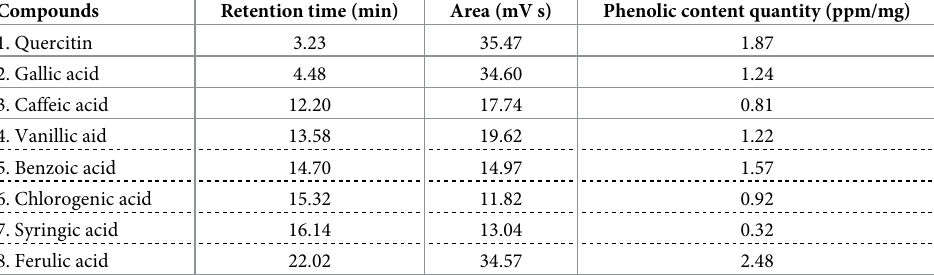
Table 4. The qualitative and quantitative analysis of phenolic compounds in the Euphorbia nivulia Buch.-Ham. aqueous extract using HPLC.